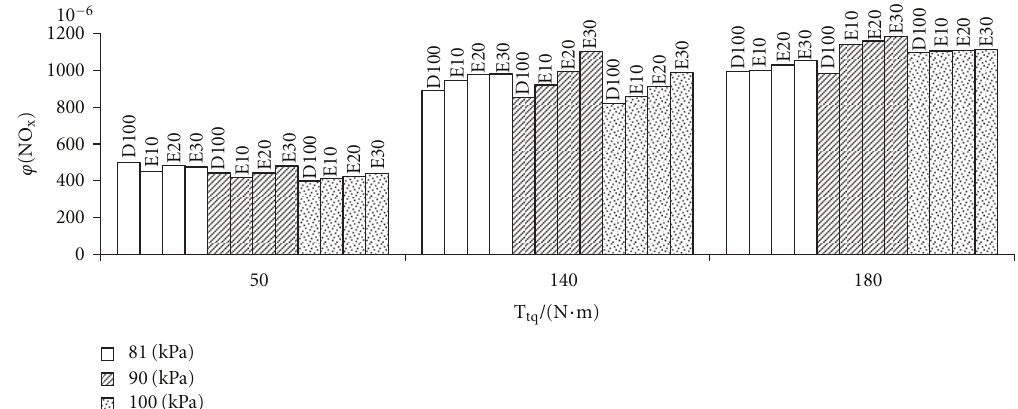
Figure 8: Comparison of NO x emission of di ff erent atmospheric pressure and mix proportion at speed1400